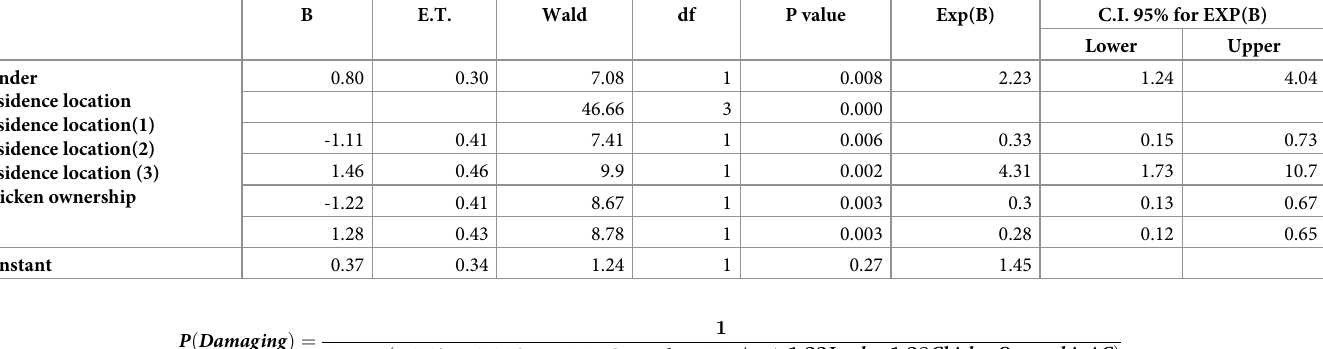
Table 2. Coefficients of the logistic binomial model for the complete set of interview data to identify which factors are significant in the perception of Spizaetus isi- dori by the inhabitants of Colombia. The variables included in the first step were gender, age, level of education, residence location, time of residence, and chicken ownership. B E.T. Wald df P value Exp(B) C.I. 95% for EXP(B)